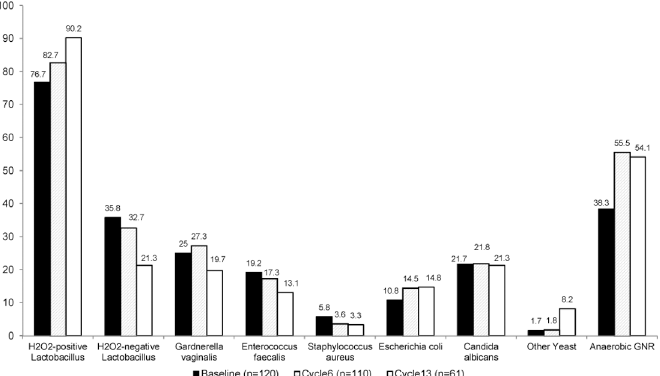
Fig 2. Prevalence of selected vaginal microbiota by assessment window. Visit timing: Cycle 6 (targeted at Day 144 [beginning of Cycle 6], range 2 to 251); Cycle 13 (targeted at Day 358 [12 cycles plus 21 days of use during cycle 13], range 252 to